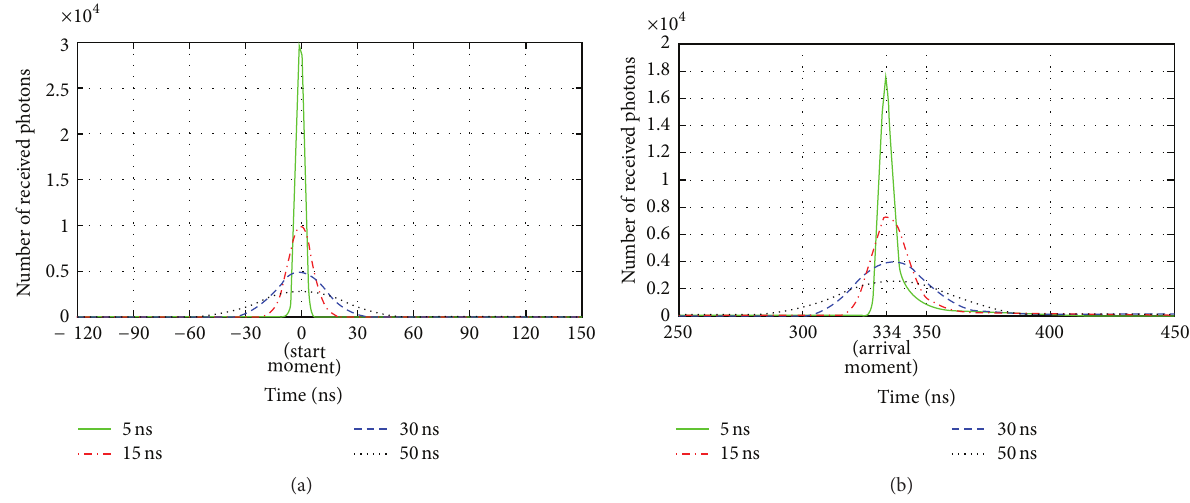
Figure 5: Temporal profiles of laser pulse of various pulse widths in rain ((a) initial signal; (b) received signal).